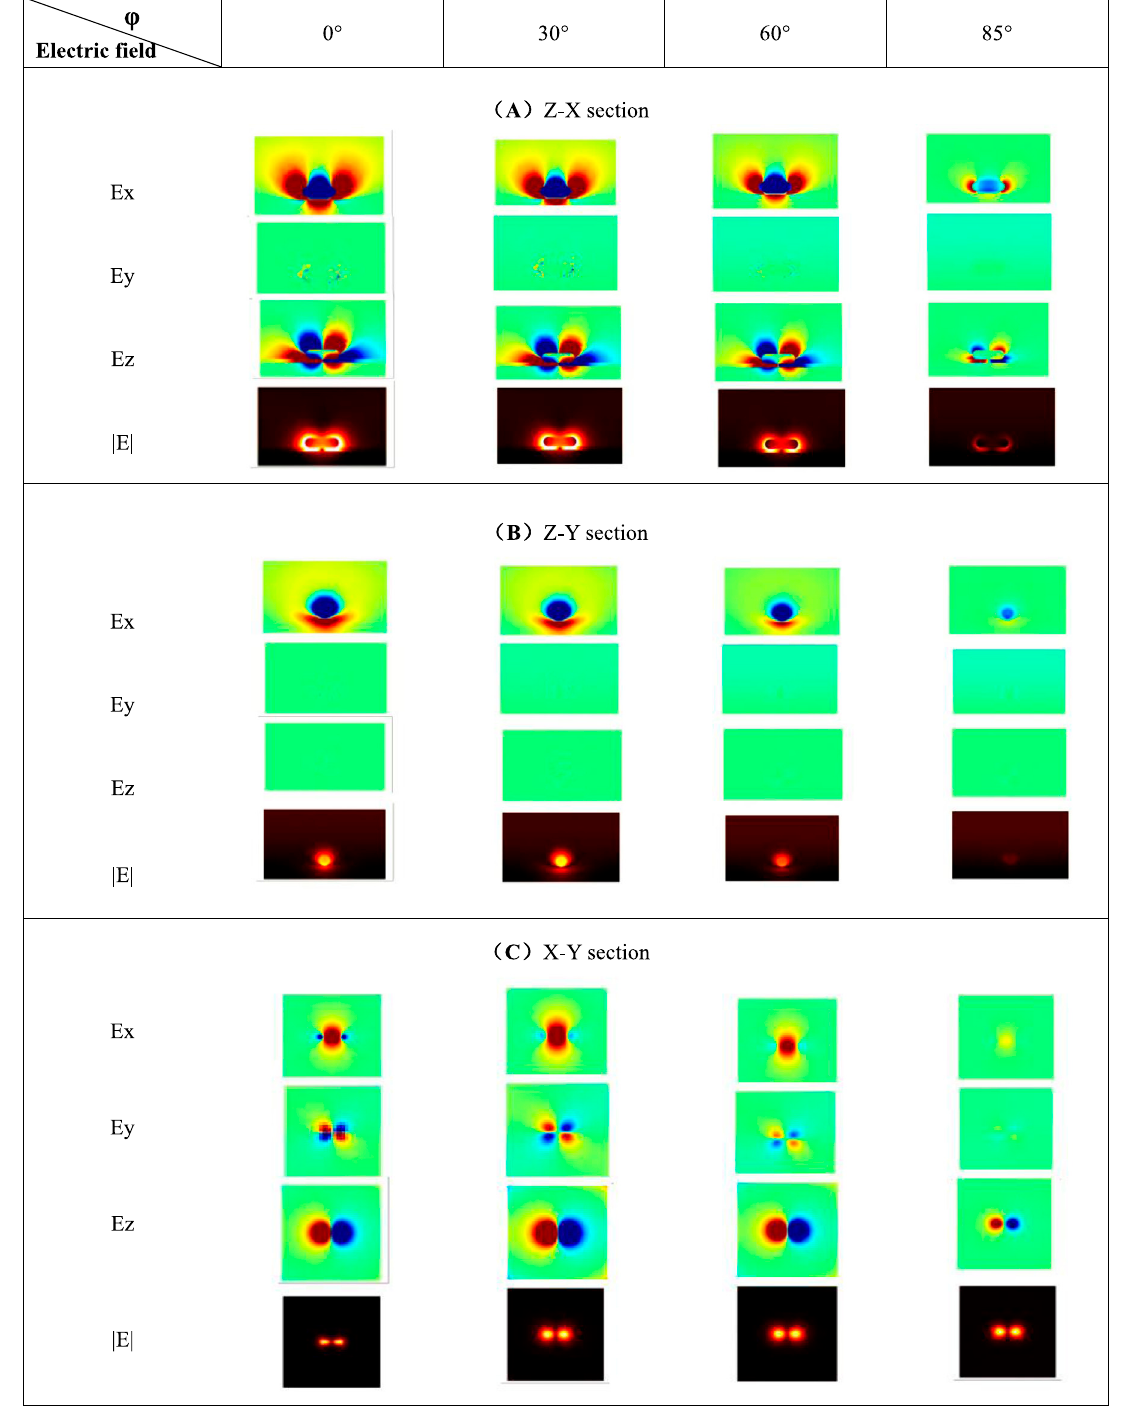
Table 2 are plotted as Figure 4 , and three straight lines with different slopes are obtained by fi tting. As the thickness